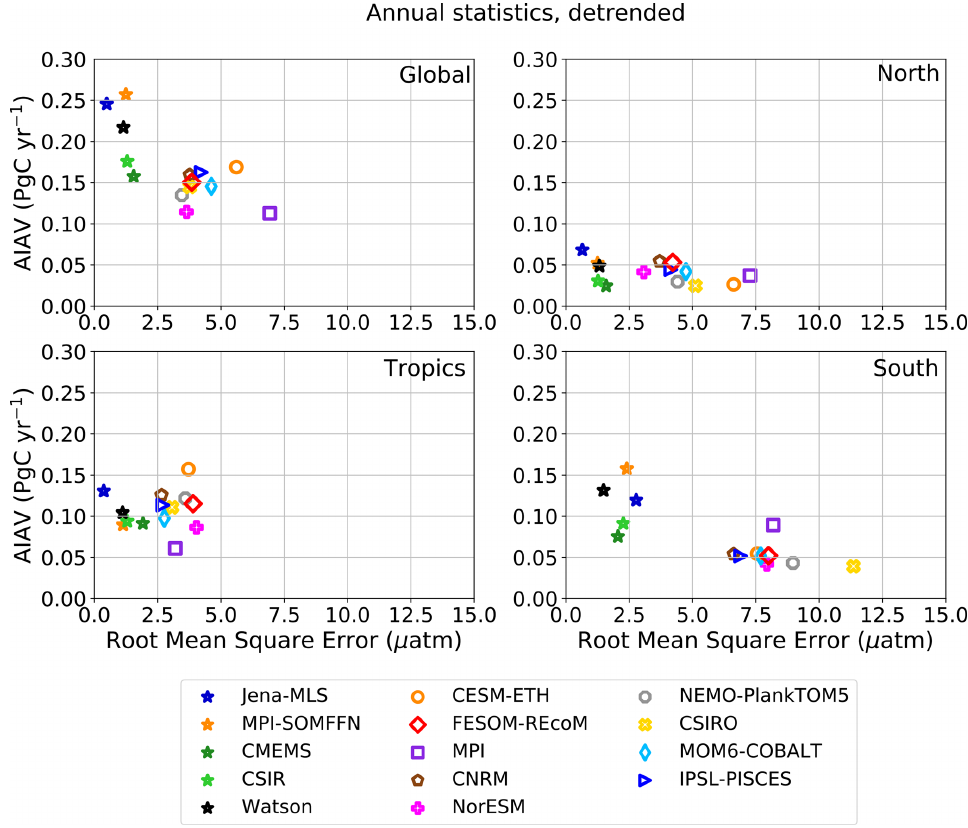
Figure B1. Evaluation of the GOBMs and flux products using the root mean squared error (RMSE) for the period 1985 to 2019, between the individual surface ocean p CO 2 estimates and the SOCAT v2020 database. The y axis shows the amplitude of the interannual variability (A-IAV, taken as the standard deviation of a detrended time series calculated as a 12-month running mean over the monthly flux time series; Rödenbeck et al., 2015). Results are presented for the globe, north ( > 30 ◦ N), tropics (30 ◦ S–30 ◦ N), and south ( < 30 ◦ S) for the GOBMs (see legend circles) and for the p CO 2 -based flux products (star symbols). The five p CO 2 -based flux products use the SOCAT database and therefore are not fully independent from the data (see Sect.